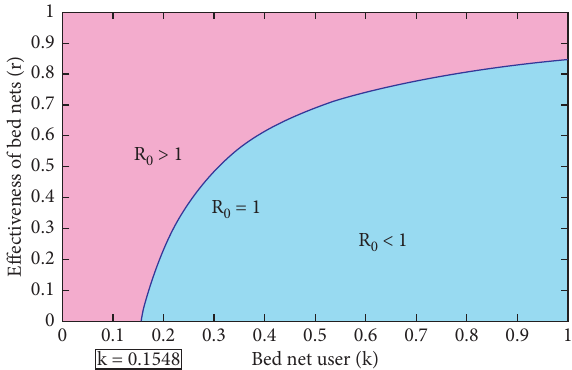
Figure 8: Parameters b and u with the critical line R different values of r when k �